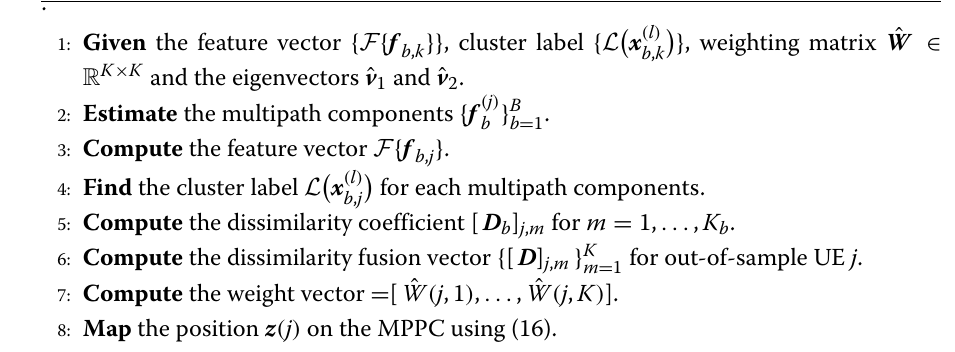
Algorithm 2 The EMPCC for UE j , j / ∈ { 1, . . . , K }